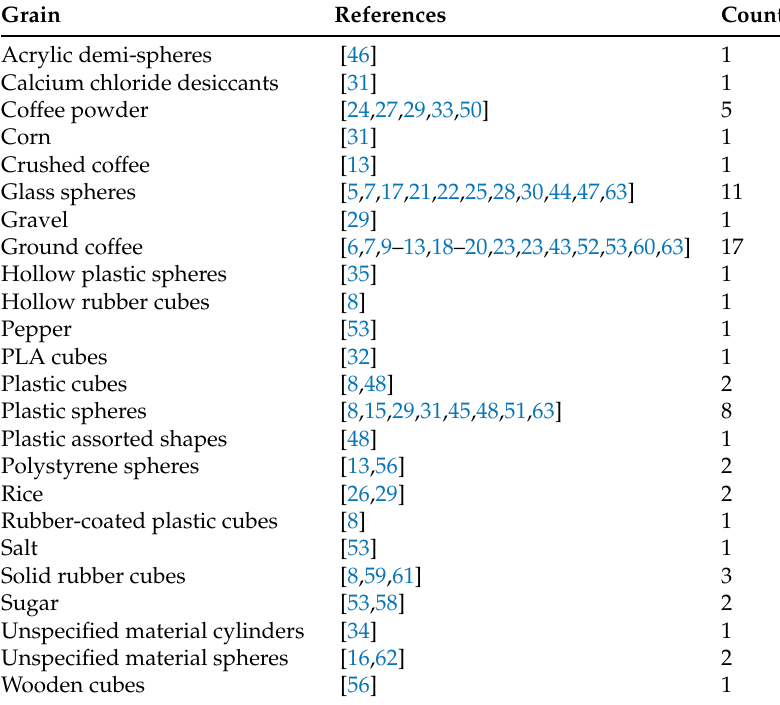
Table 2. Frequency of various grain materials and geometries.